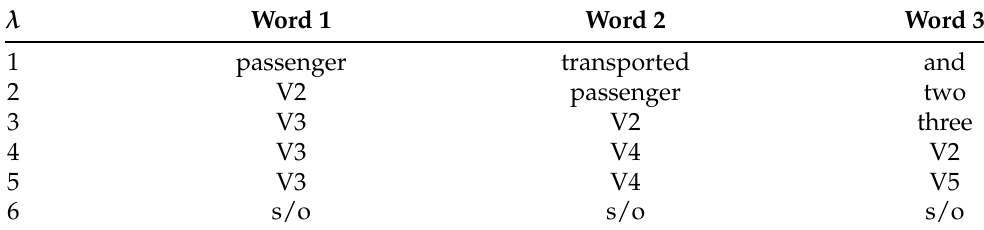
Table 7. The three most important words in the HAN